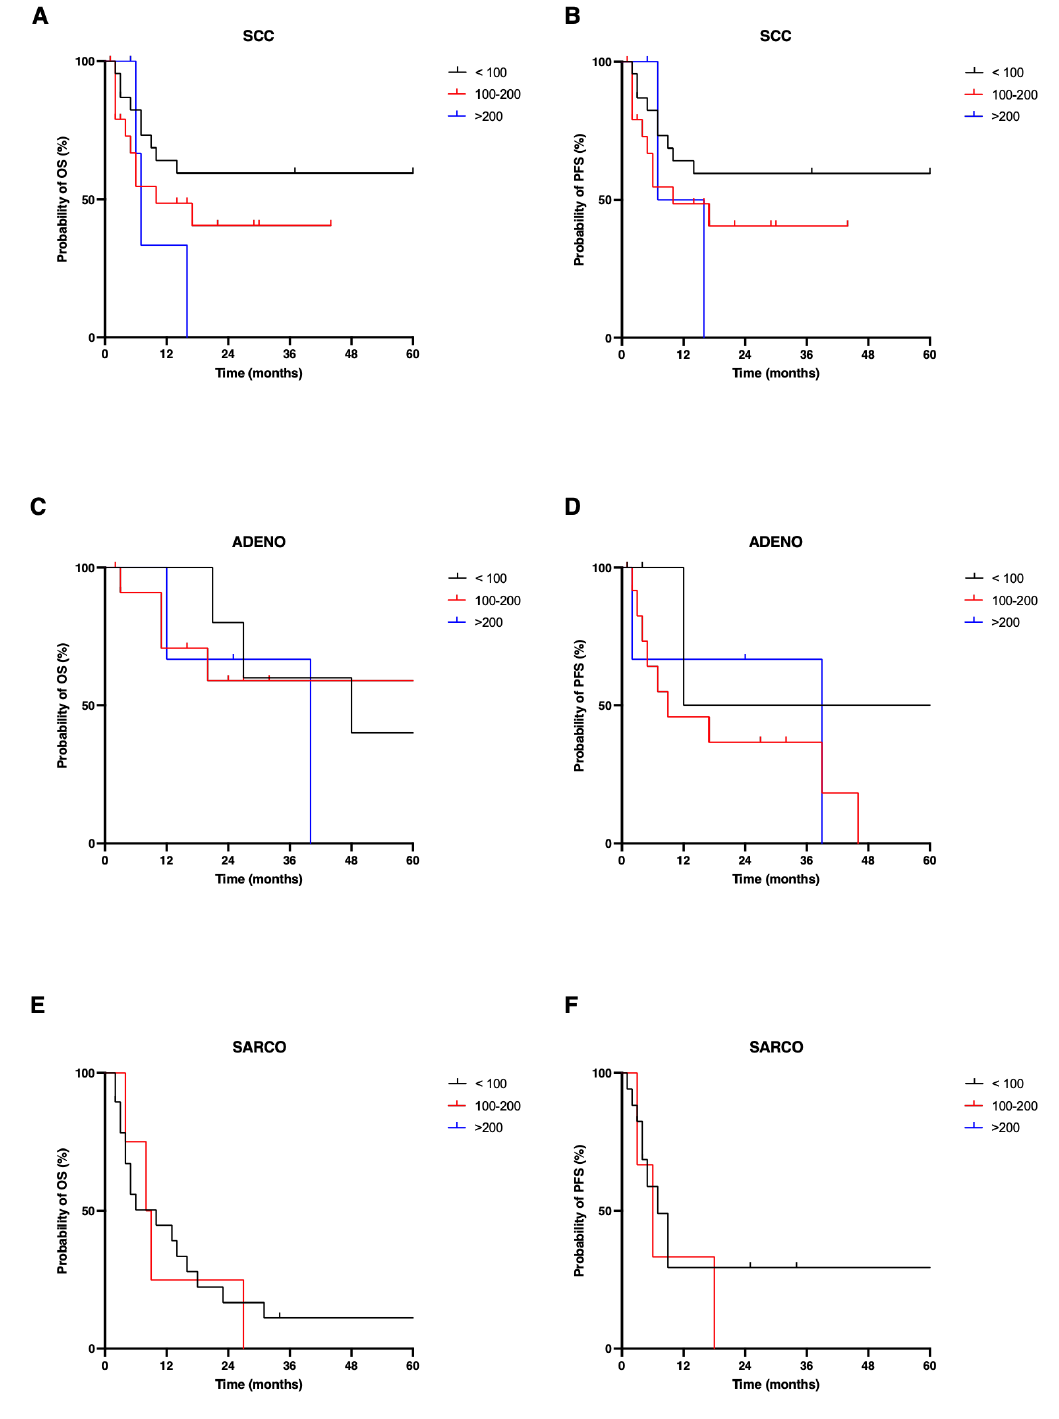
Figure 3. Overall (OS) and progression-free survival (PFS) in variant histologies of bladder cancer. Expression of Nectin-4 was classified as low (H-score < 100, black), intermediate (H-score 100–200, red), and high (H-score > 200, blue). Group comparisons were performed by log-rank test. OS (A) and PFS (B) of squamous cell carcinoma (SCC), OS (C) and PFS (D) of adenocarcinoma (ADENO) and OS (E) and PFS (F) of sarcomatoid urothelicarcinoma (SARCO) were analyzed. In SARCO, there are no patients with a H-score of >200. OS, overall survival; PFS, progression-free survival; SCC, pure squamous cell carcinoma of the bladder; ADENO, adenocarcinoma of the bladder; SARCO, sarcomatoid urothelial carcinoma of the bladder.